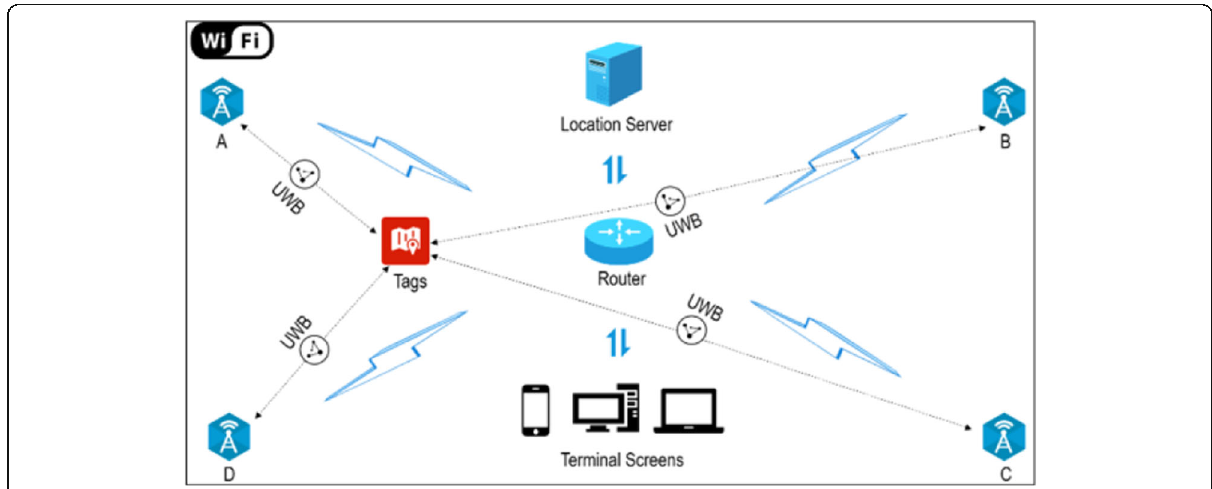
Fig. 3 System structure. The system consists of active tags, four base stations (A, B, C, and D), a router, a location server, and several display terminals. The tags send an ultra-wideband signal in a fixed time slot; each base station intercepts this signal, calling the ranging algorithm to get the distance between base stations and the